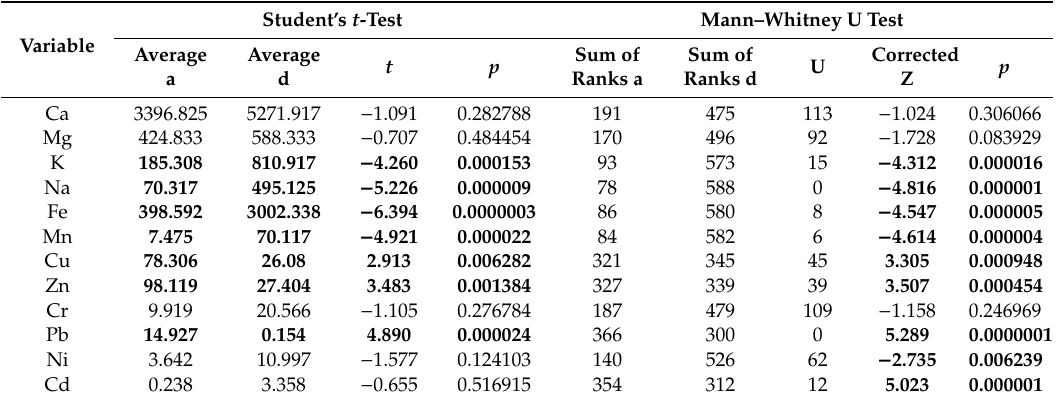
Table 5. Analysis of di ff erences between the composition of new (a) and composted samples after 50 h irradiation (d)—the highlighted results are significant with p <